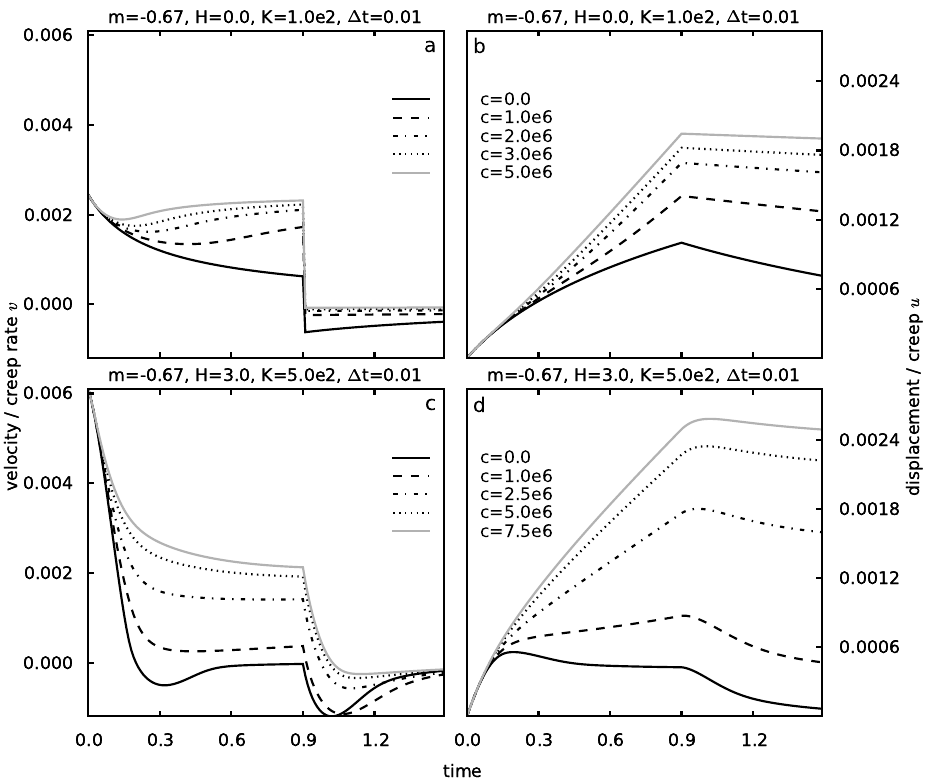
Fig. 4. (a, c) Velocity (creep rate) v at the slab surface as a function of time. (b, d) Displacement (creep) u at the slab surface as a function of time. In (a, b) solutions of v and u are displayed for different values of the memory damping factor c while H = 0. In (c, d) solutions of v and u are shown for various values of c and H = 3.0. Other parameters are as displayed in the plot headers. All fields ( u , v , t ) are non-dimensional.